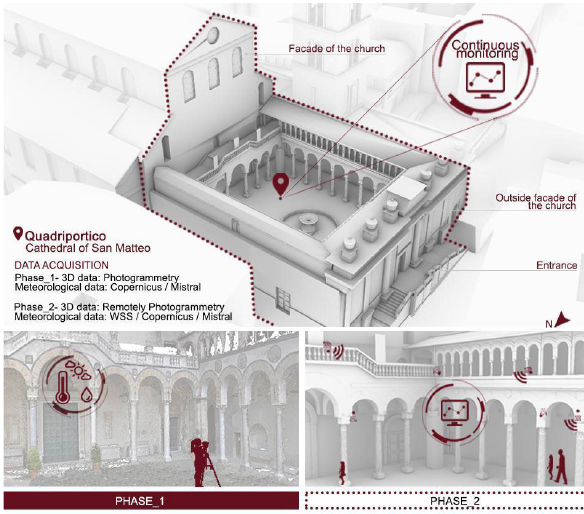
Figure 2 . Data acquisition of the continuous monitoring system in the Quadriportico of the Cathedral of San